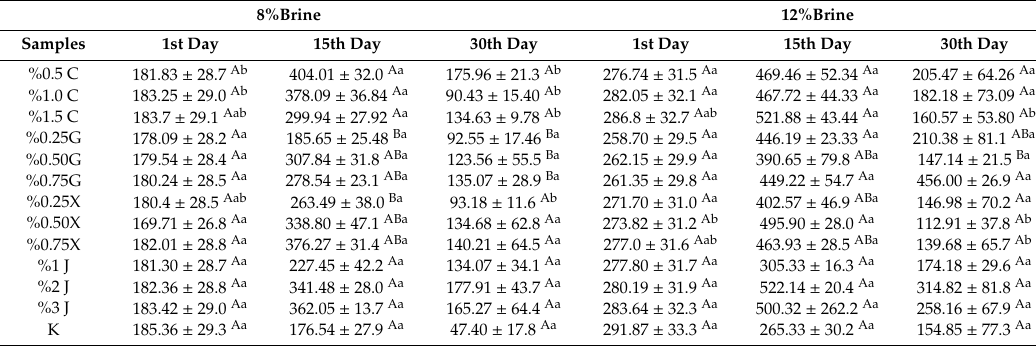
Table 8. Chewiness (g) of cheese samples during